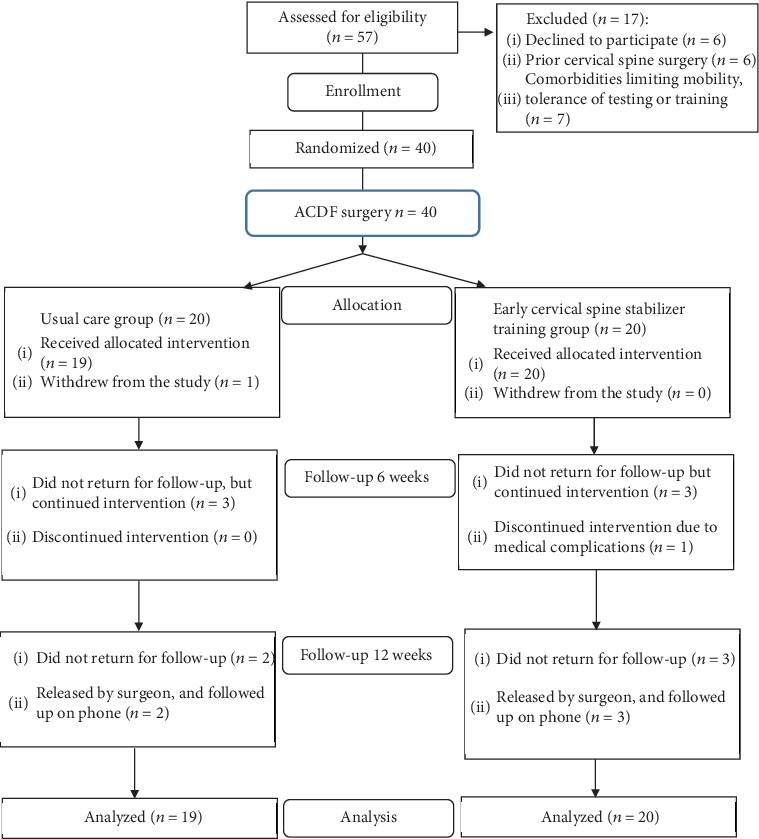
Consort diagram.